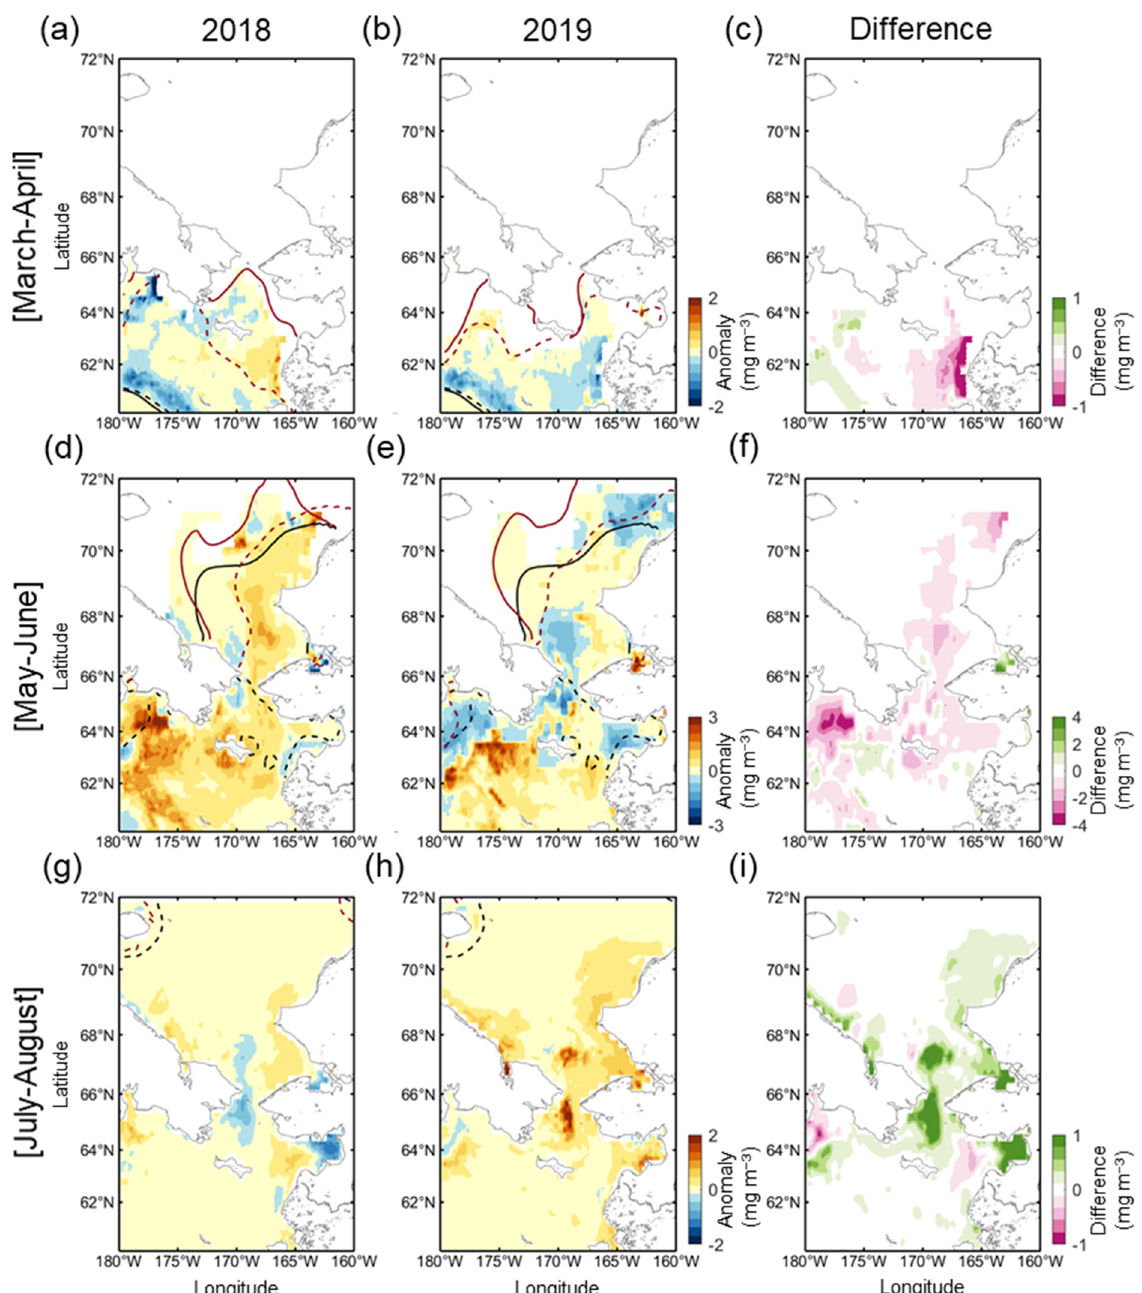
Figure 5. The spatial distribution of Chl-a anomalies in ( a , d , g ) 2018 and ( b , e , h ) 2019, and ( c , f , i ) the difference between Chl-a anomalies in both years during early spring (March–April, top panel), spring (May to June, middle, middle panel) and summer (July to August, bottom panel) seasons. The thick black dotted and solid lines indicate the climatological marginal sea ice edges of the previous and later months (e.g., May and June in Figure 5d,e), respectively. The thick brown dotted and solid lines are those in 2018 and 2019. The difference was calculated by subtracting the Chl-a anomaly of 2018 from that of 2019.